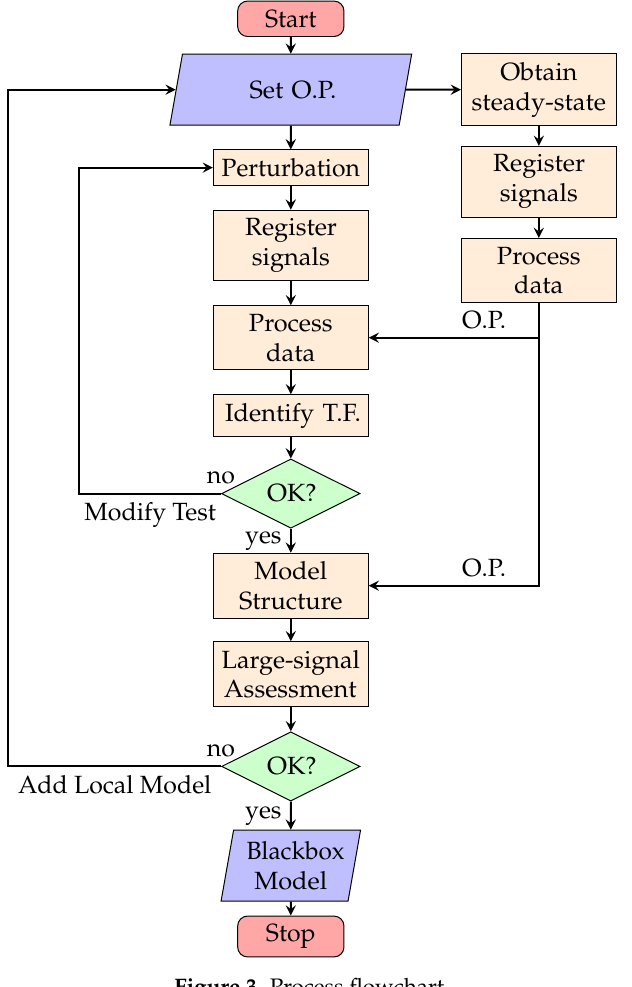
Figure 3. Process